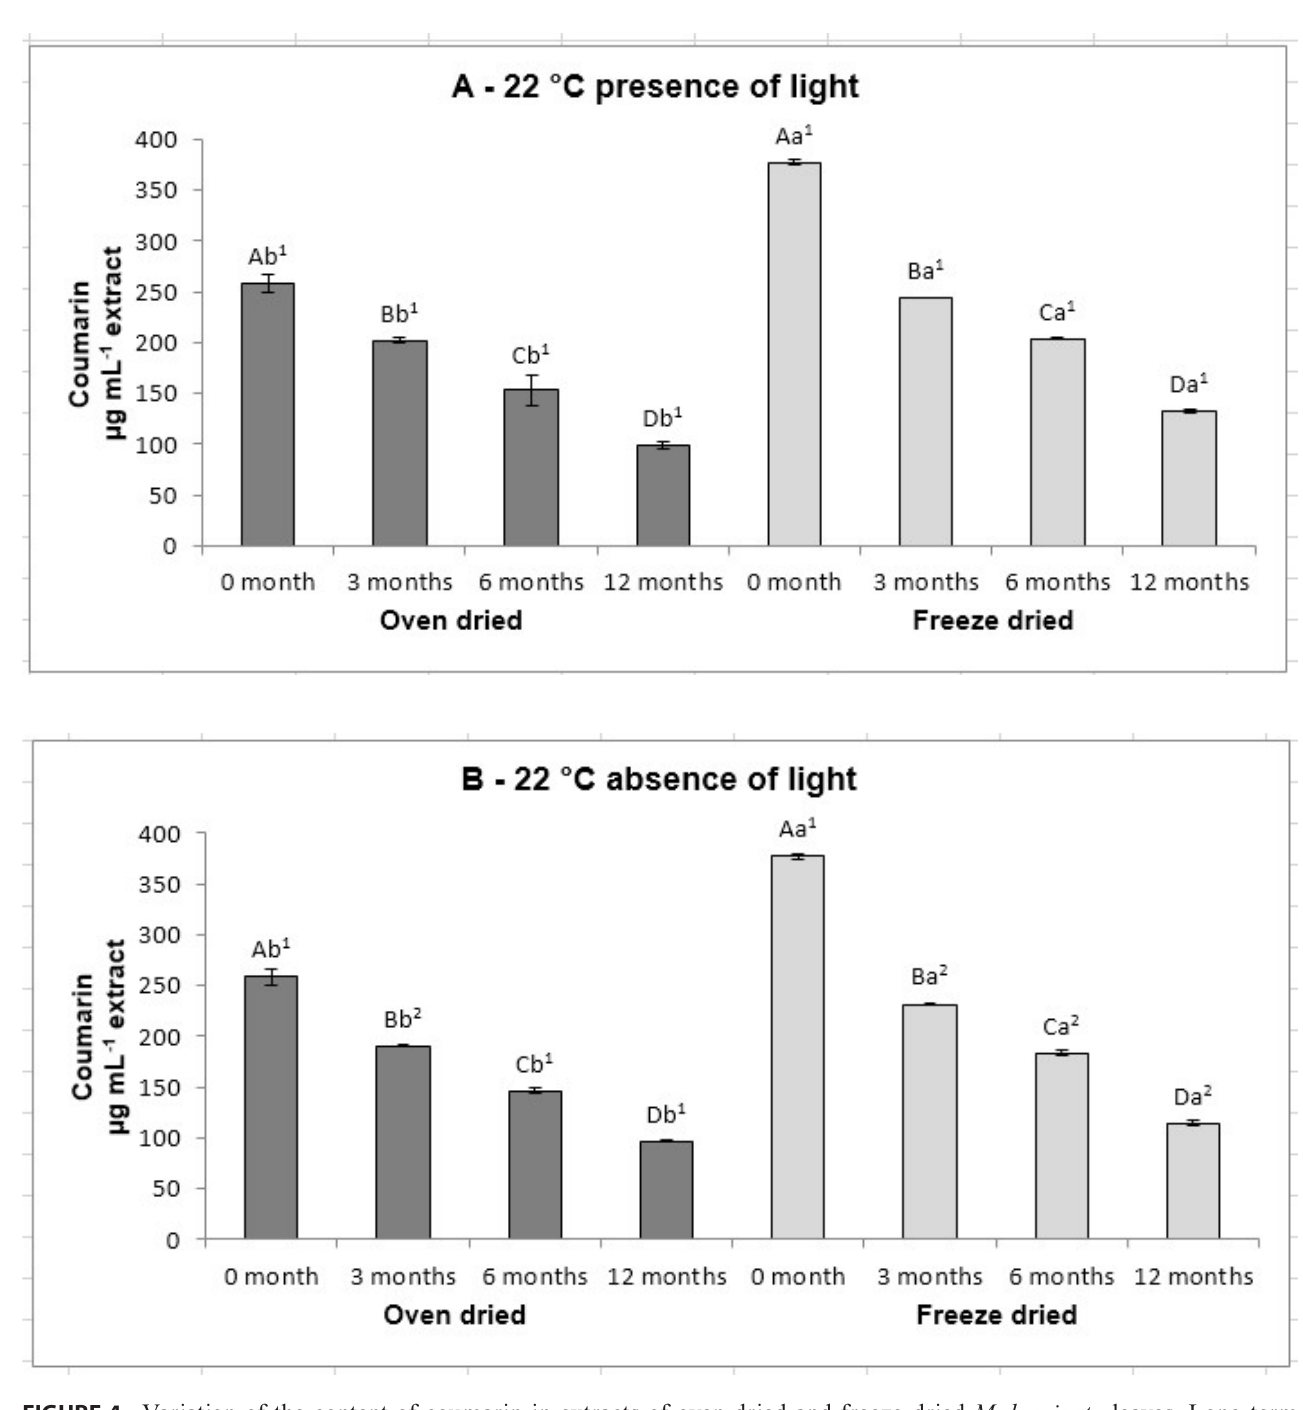
FIGURE 4 - Variation of the content of coumarin in extracts of oven dried and freeze-dried M. laevigata leaves. Long term stability study at 22 ºC in the presence of light (A) and absence of light (B). Capital letters indicate statistically significant (p<0.05) differences within the same drying method (0, 3, 6 and 12 months). Lowercase letters indicate statistically significant (p<0.05) differences between drying methods at the same time. Numerals indicate statistically significant (p<0.05) differences between storage with and without light. Experiment performed in triplicate. Error bars indicate standard